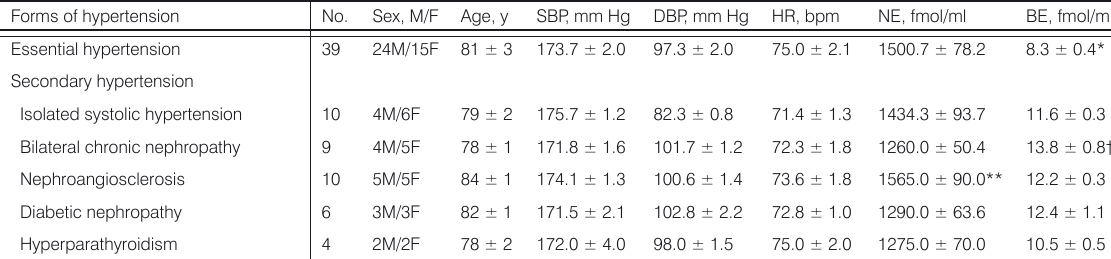
Table 1. Hemodynamic and neuro-hormonal characteristics of elderly hypertensive